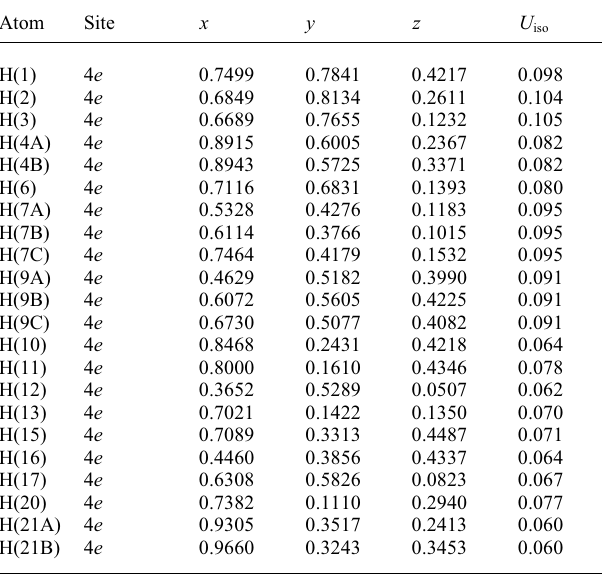
Table 2. Atomic coordinates and displacement parameters (in Å 2 )